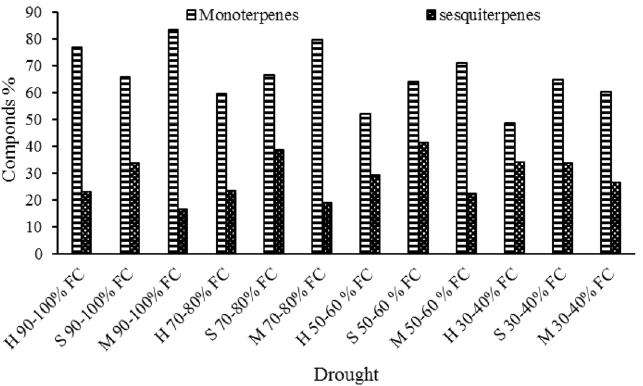
Figure 15. The amount of monoterpenes and sesquiterpene compounds in different genotypes under irrigation